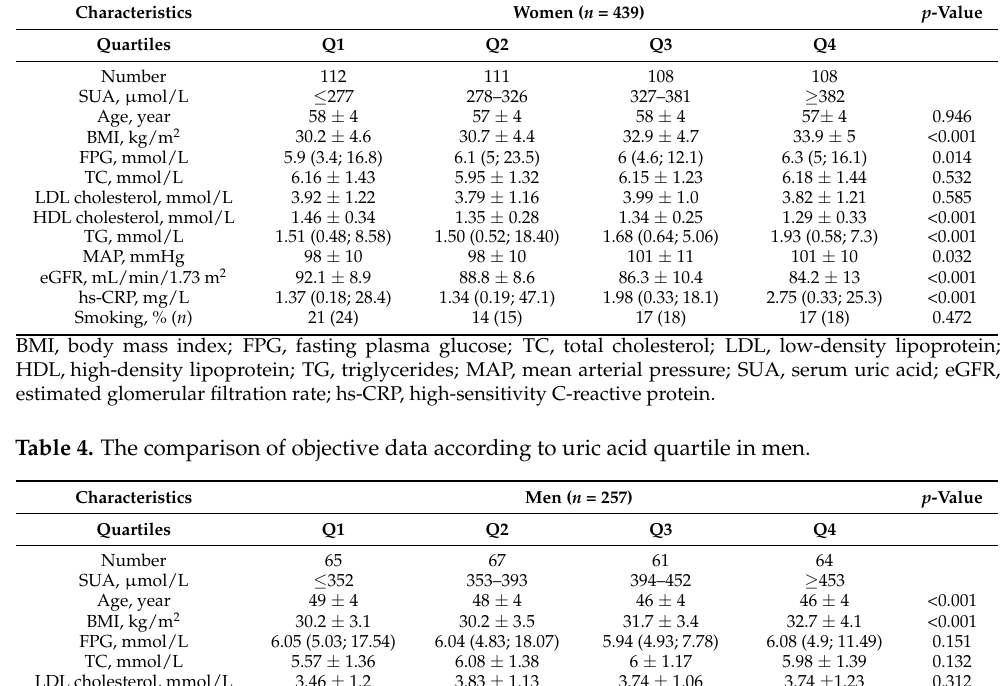
Table 3. The comparison of objective data according to uric acid quartile in women. Characteristics Women ( n = 439)